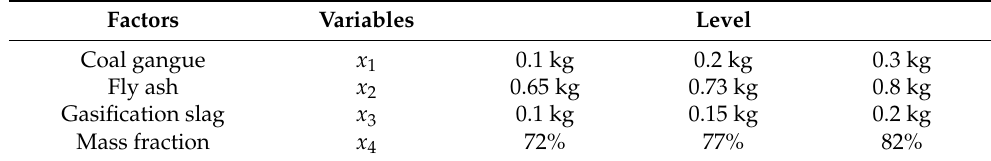
Table 2. Test factor range settings.